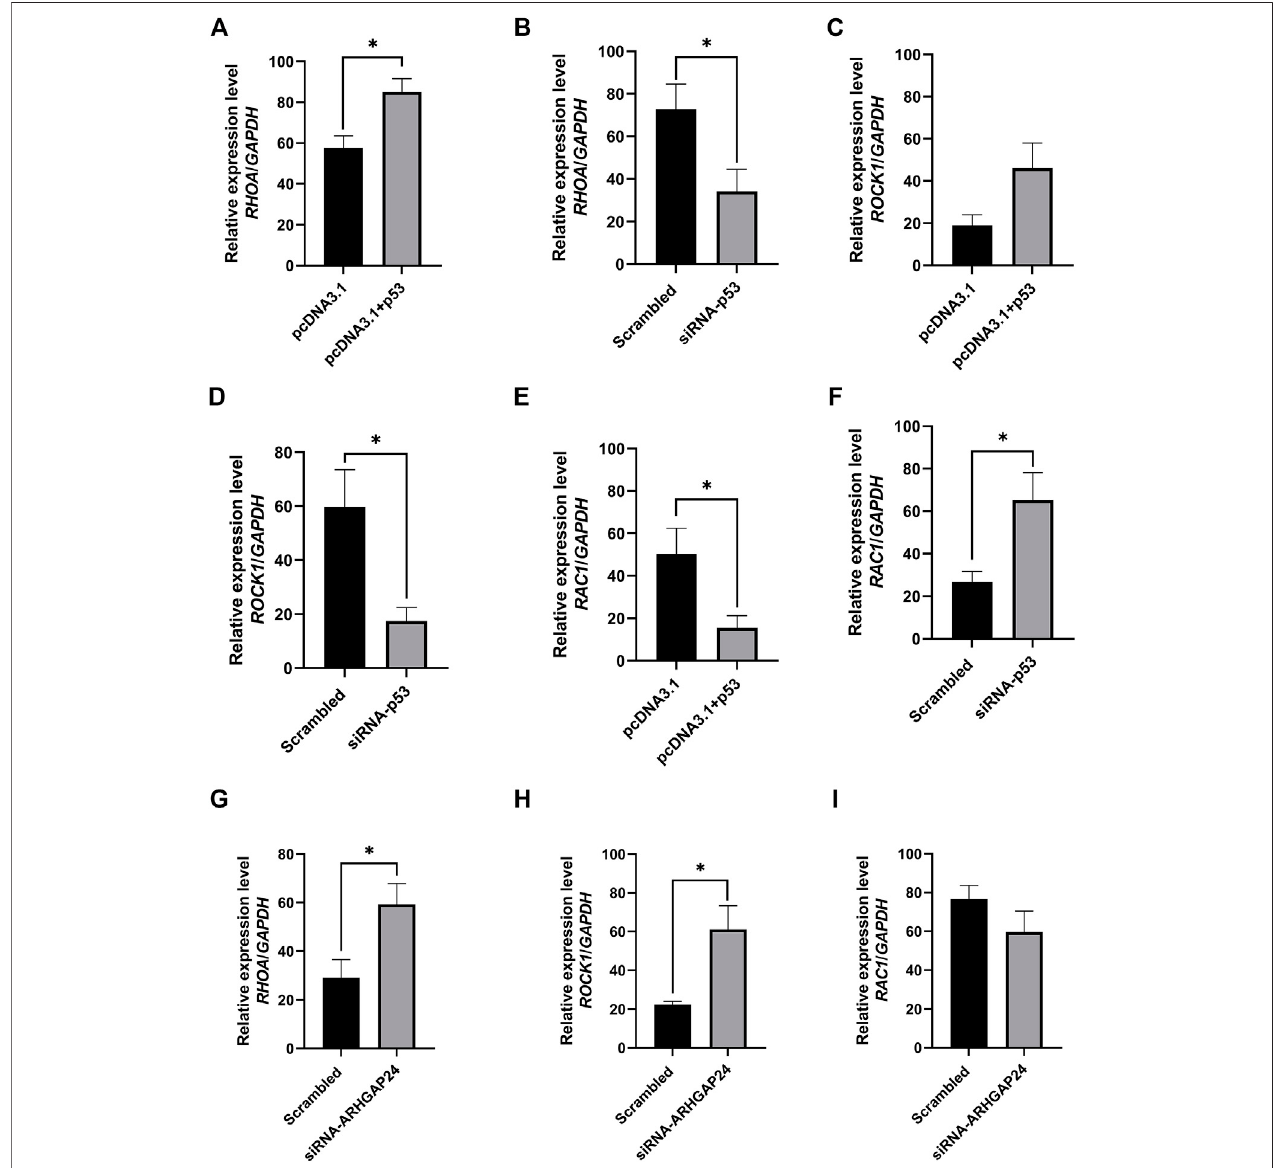
FIGURE 6 | Transcription factor p53 regulates axon guidance pathway – related gene expression in porcine neural cells. (A) mRNA level of RHOA after p53 overexpression. (B) mRNAlevelof RHOA afterp53knockdown. (C) mRNAlevelof ROCK1 afterp53overexpression (D) mRNAlevelof ROCK1 afterp53knockdown (E) mRNAlevelof RAC1 afterp53overexpression. (F) mRNAlevelof RAC1 afterp53knockdown. (G) mRNAlevelof RHOA after ARHGAP24 knockdown. (H) mRNAlevelof ROCK1 after ARHGAP24 knockdown. (I) mRNAlevelof RAC1 after ARHGAP24 knockdown.* p < 0.05and ** p < 0.01.Scrambled:anegative controlforsiRNAas a scrambled sequence of the siRNA target